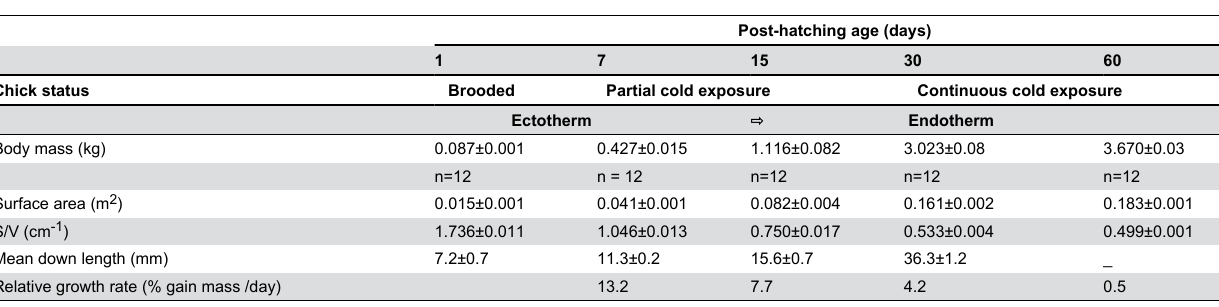
Table 2. Morphological